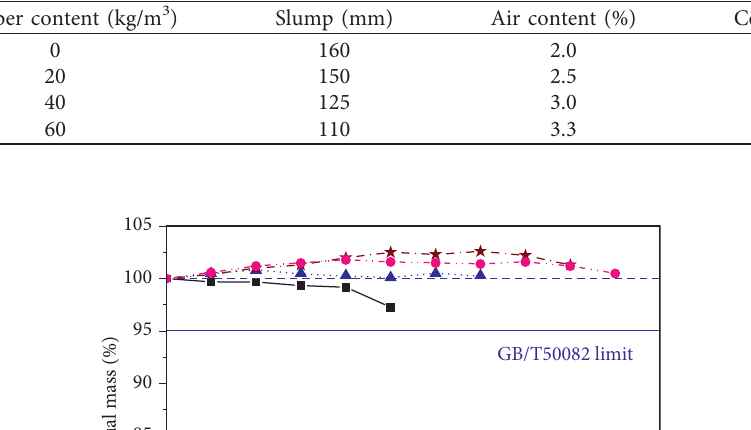
Table 3: Slump, air content, and compressive strength of the concrete.